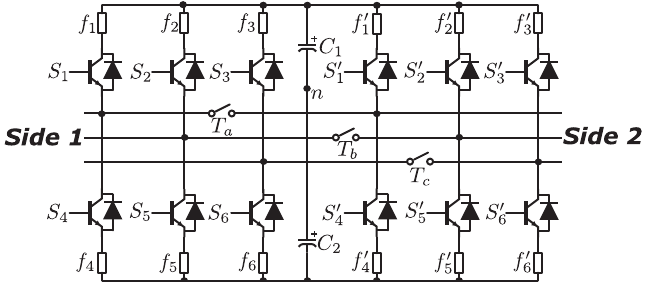
Figure 5. Switch-level fault protection in a back-to-back power converter.The bidirectional switches T a , T b or T c are gated during a switch failure, replacing the faulty switch ( S 1 , ..., S 6 , S (cid:48)